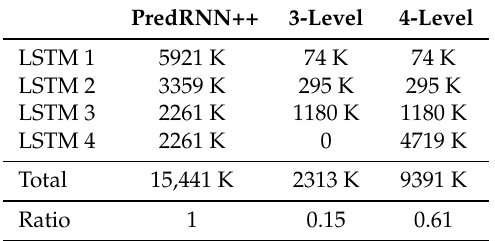
Table 3. Comparison of the number of convolutional weights of LSTMs at different levels, bias